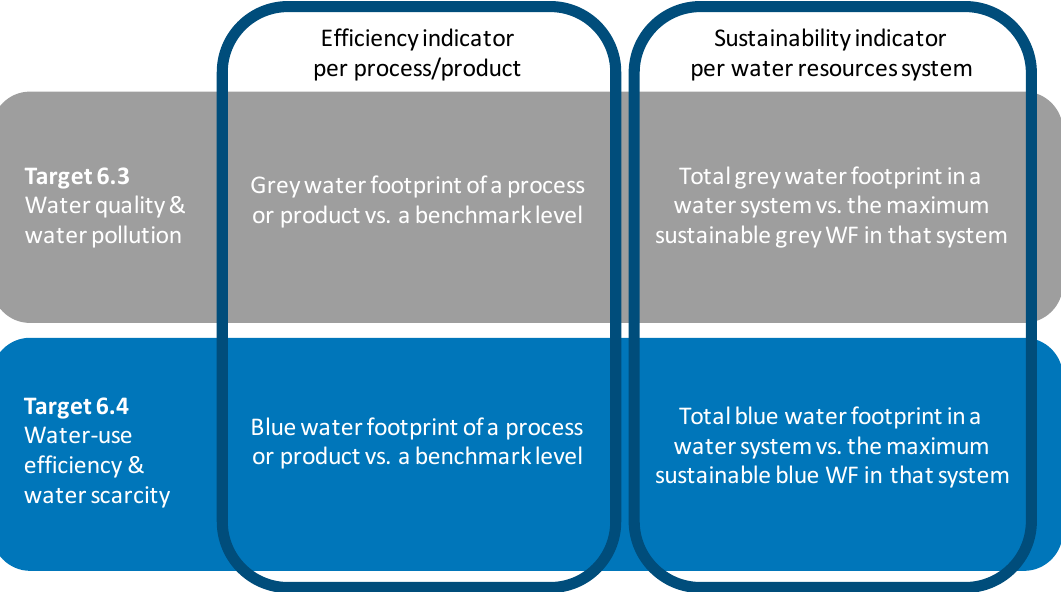
Figure 1. Using water footprint metrics to monitor progress towards SDG targets 6.3 and 6.4.